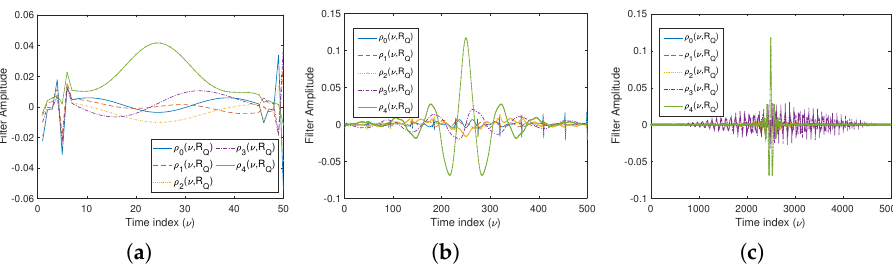
Figure 4. Time representation of the pre-designed order dependent FIR filter ρ n ( ν , R Q ) with length L = ( a ) 25, ( b ) 250 ( c )